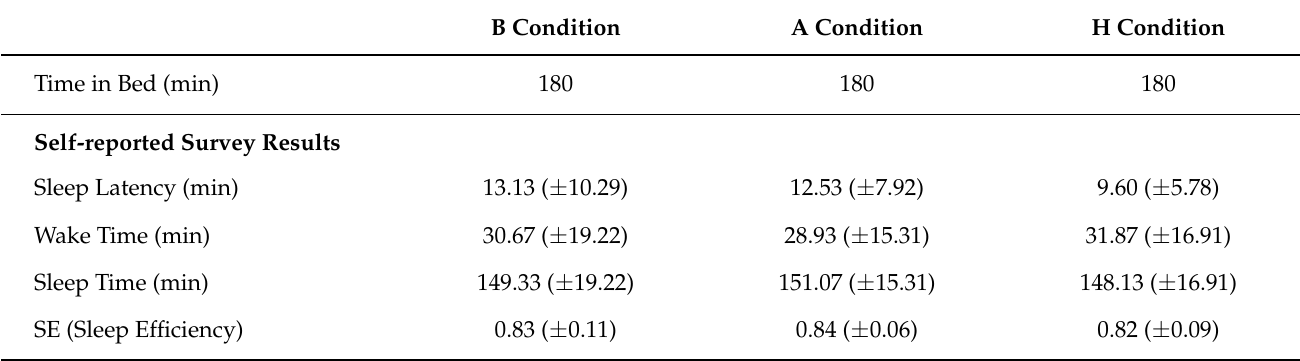
Table 4. Self-reported sleep quality after the nap of the participants in three experimental conditions.